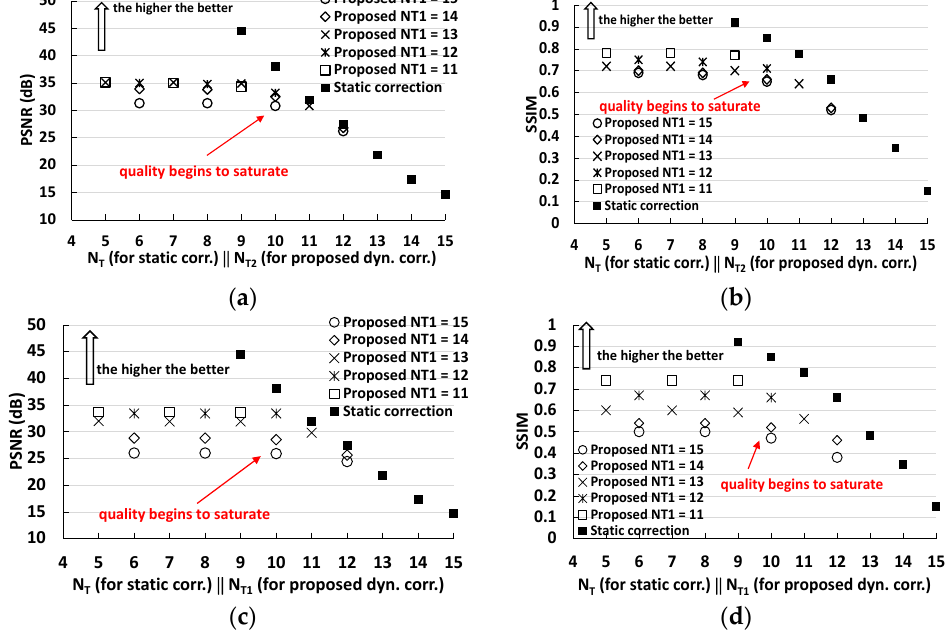
Figure 11. Output quality analysis for a 7 × 7 Gaussian filter: comparison between the standard static approach and the proposed dynamic technique. ( a , b ) F = 4, ( c , d ) F = 8.